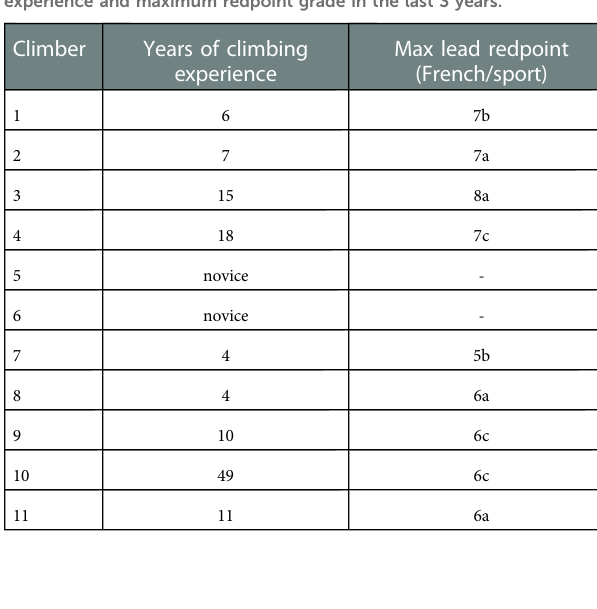
TABLE 4 Crosstalk errors with a nominal force ranging between 0 and 1600N. Error bounds expressed as a percent of F N